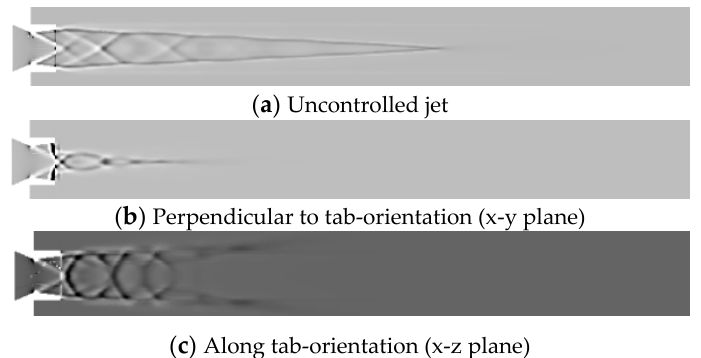
Figure 31. Schlieren views of uncontrolled and controlled jets at NPR 6 (underexpansion).